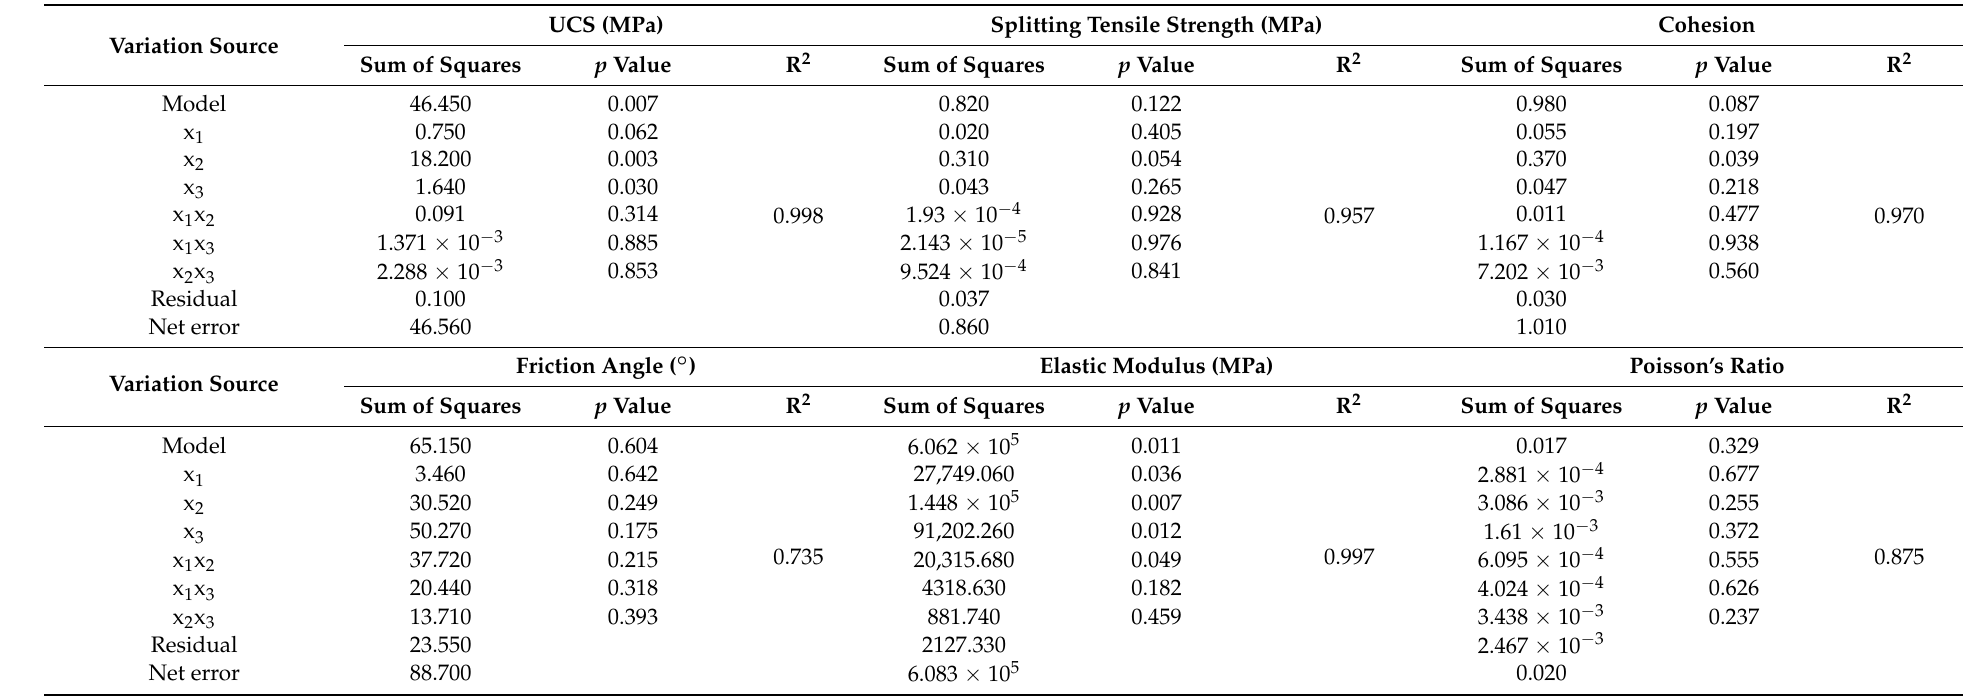
Table 10. Variance analysis of prediction model for mechanical properties of gangue paste